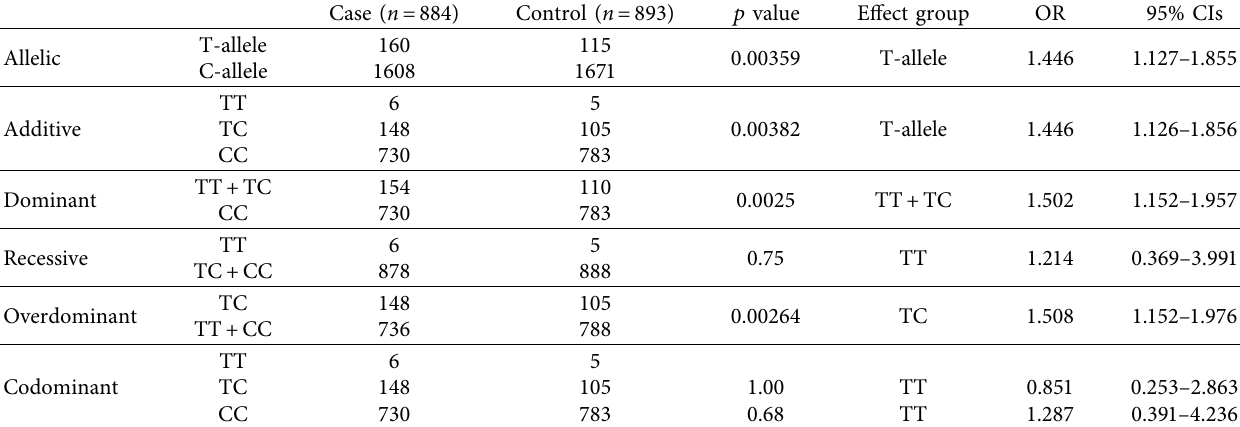
Table 2: Genotype and allele distributions of rs1800587 in the cases and controls and their associations with risk of